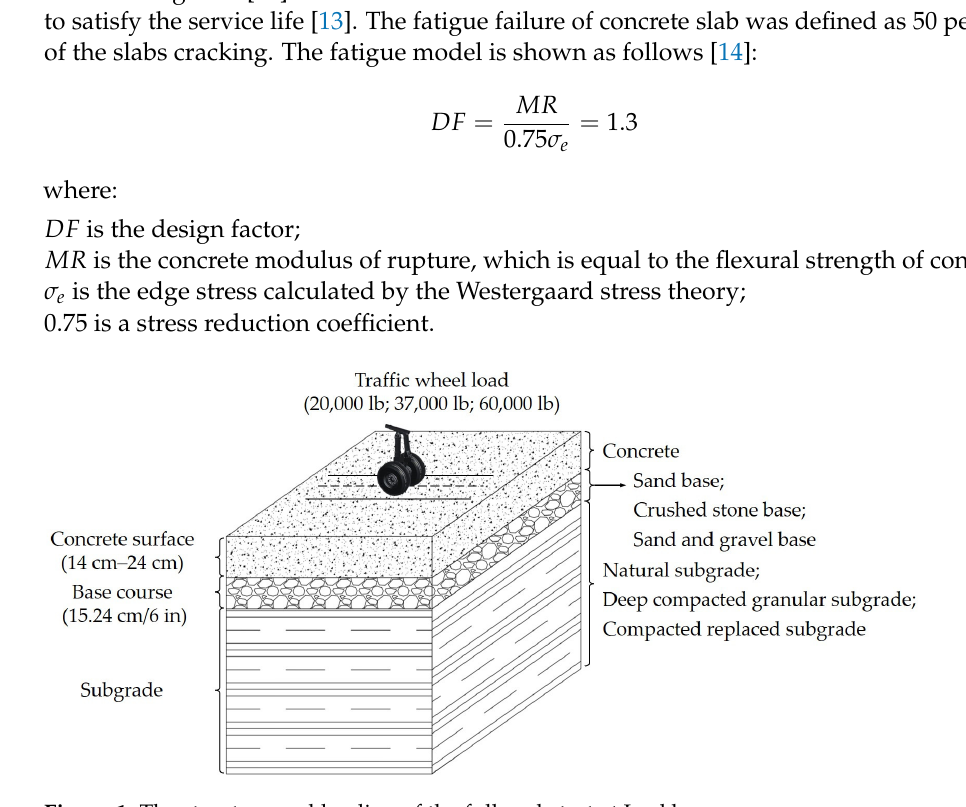
Figure 1. The structure and loading of the full-scale test at